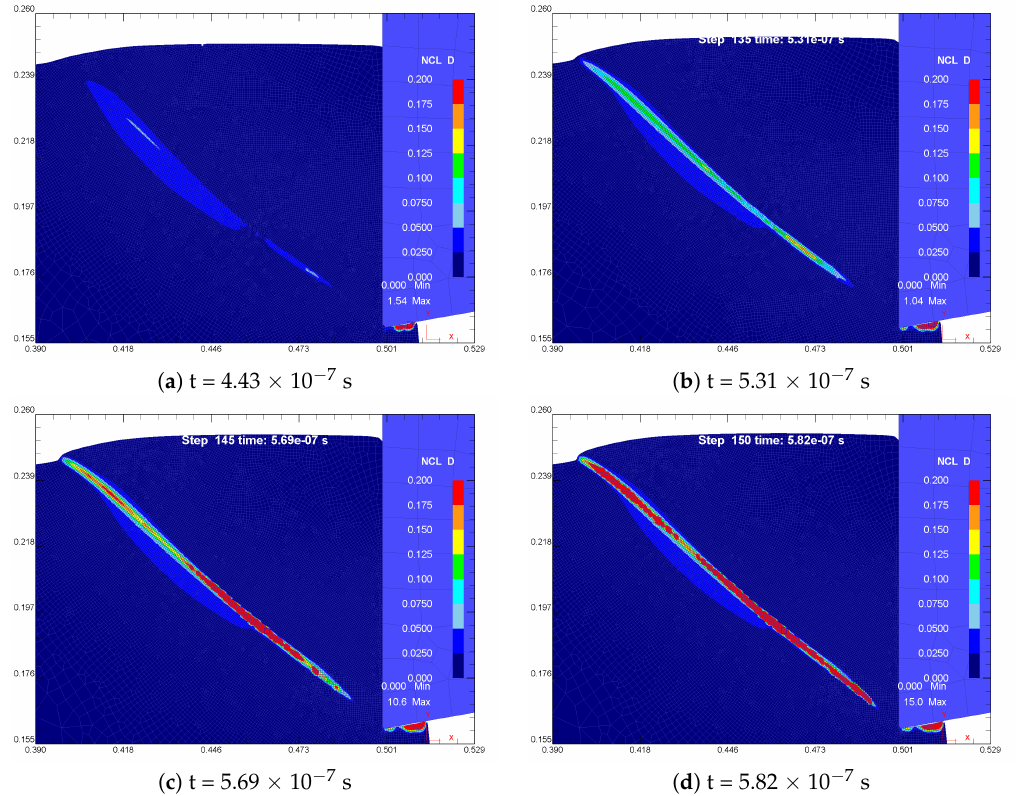
Figure 8. Evolution of damage inside the ASB. Discontinuous element degradation and coalescence inside the ASB resulting in a macrocrack; simulation with minimum element size h ≈ 0.6 µ m; Normalized Cockcroft and Latham (NCL) criterion (CDV = 0.2); cutting conditions: v = 40 m/s, feed = 0.08 mm/rev, rake angle γ = 0 ◦ ; snapshots are taken at: ( a ) t = 4.43 × 10 − 7 s, ( b ) t = 5.31 × 10 − 7 s, ( c ) t = 5.69 × 10 − 7 s, and ( d ) t = 5.82 × 10 − 7